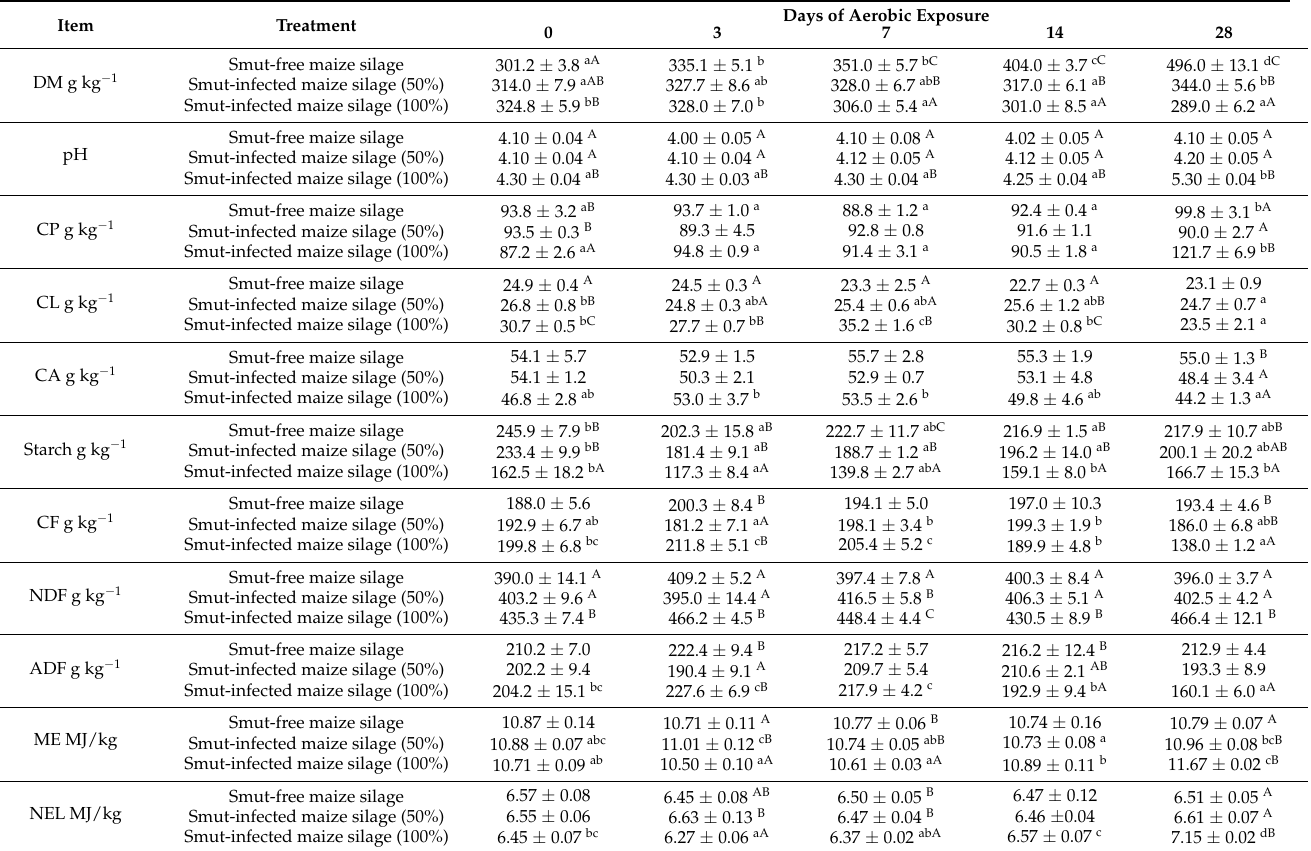
Table 2. Effect of Ustilago maydis infection rates on fermentation patterns and the nutritive value of the silage at the opening and during aerobic